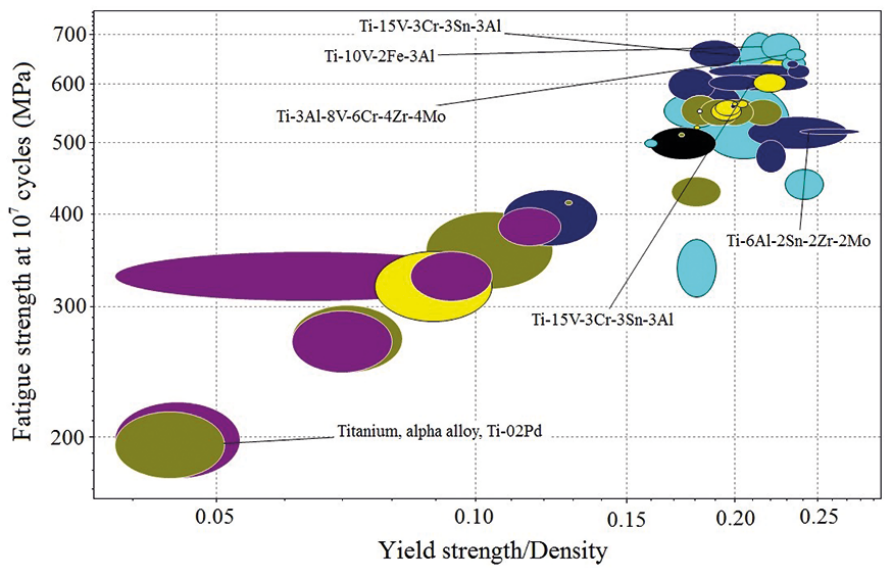
Figure 2. Material property chart for titanium landing gear beam, plotting fatigue strength at 10 7 cycles versus specific strength. Colors: Titanium alloys are in olive, alpha-beta alloys are in navy, beta alloys are in cyan, commercially pure titanium alloys are in purple, near-alpha alloys are in yellow and near-beta alloys are in